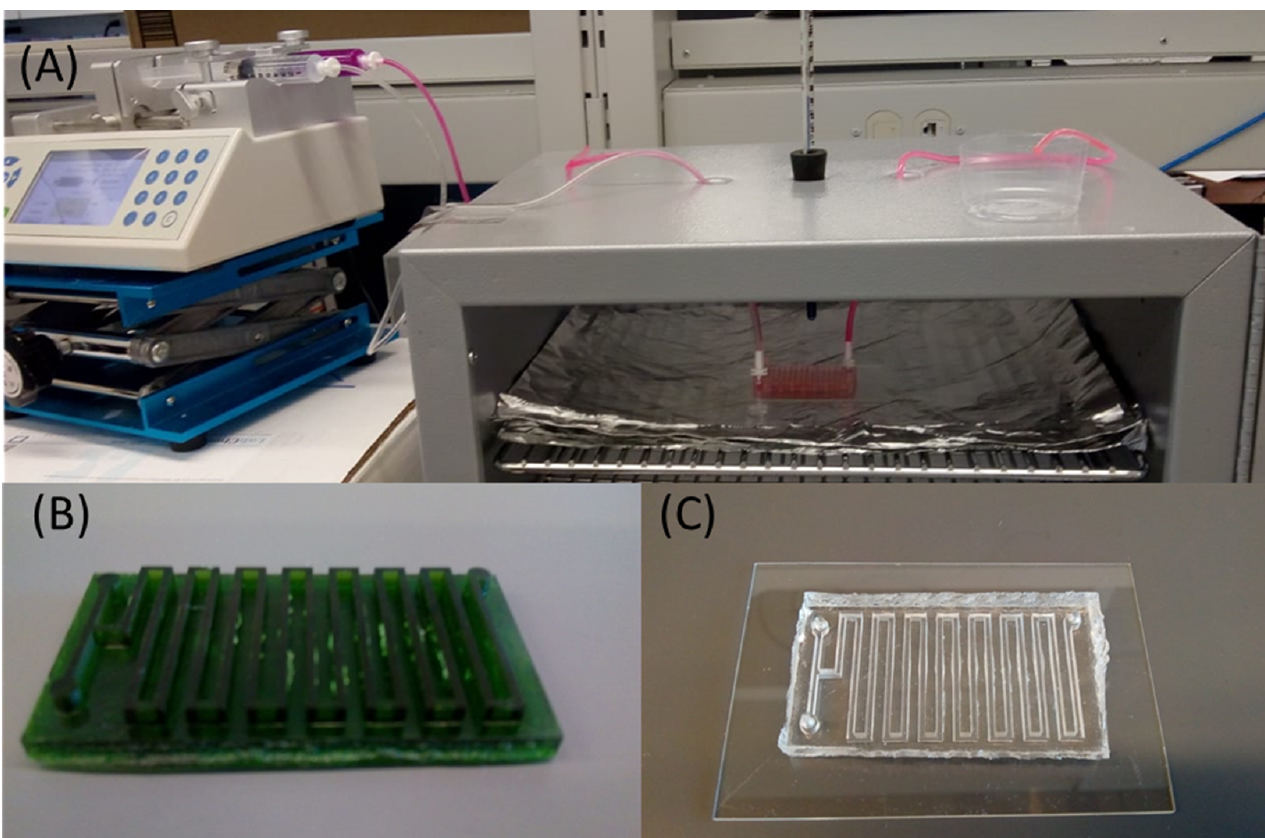
Figure 5. Operational set-up for microfluidic staining. ( A ) Microfluidic device placed inside oven with inlet and outlet tubings; ( B ) Photo of the mold used for PDMS casting; ( C ) Photo of the final bonded device.